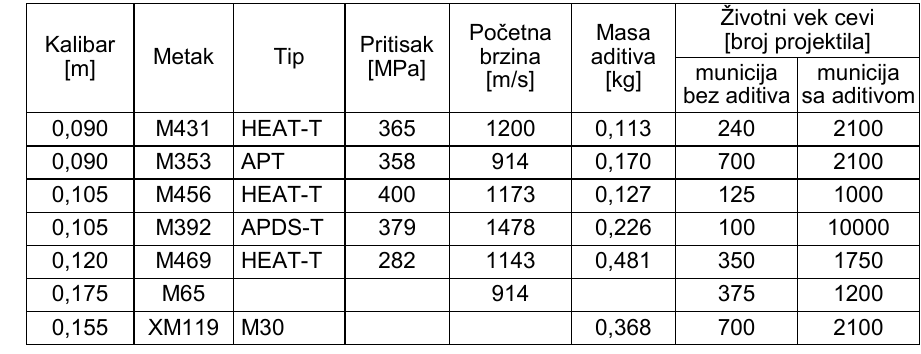
Effects of TiO 2 and wax on the barrel lifetime